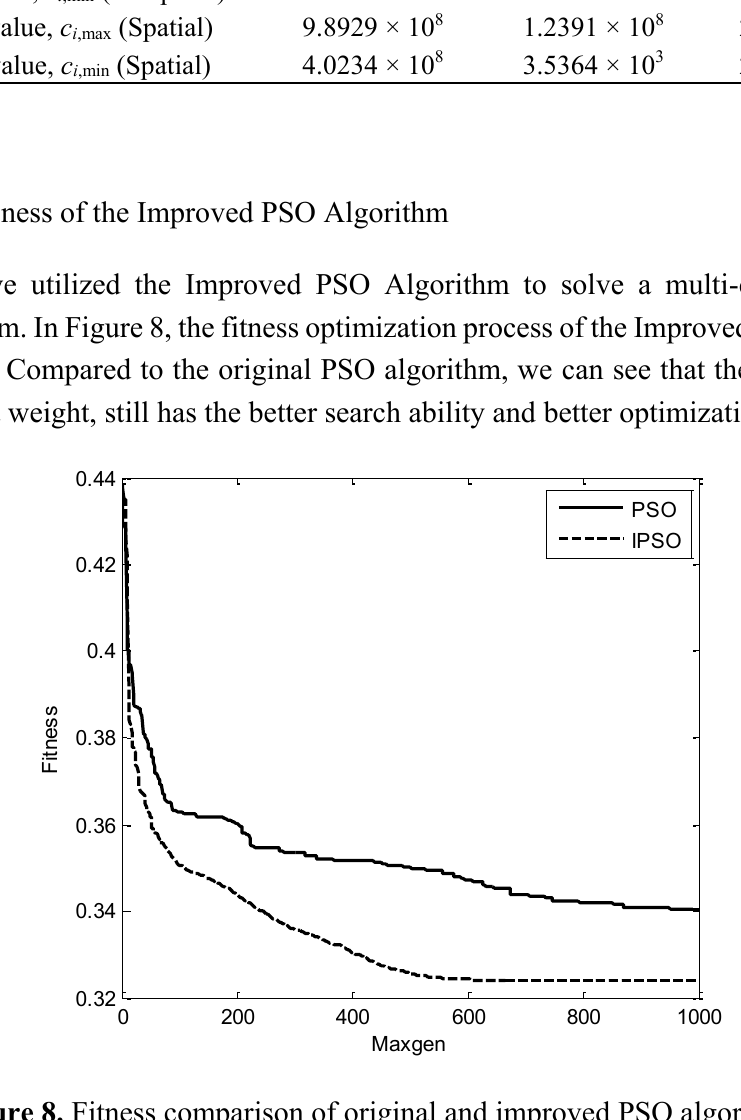
Figure 8. Fitness comparison of original and improved PSO